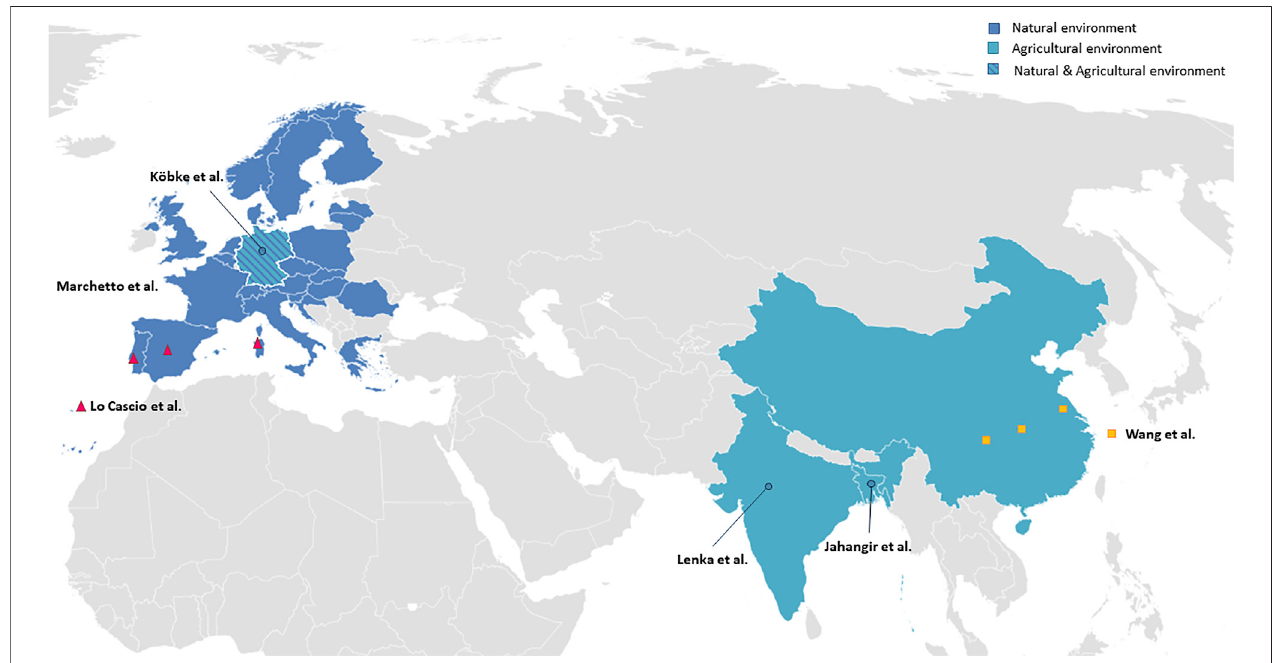
FIGURE 1 | Geographical distribution of contributions in the Research